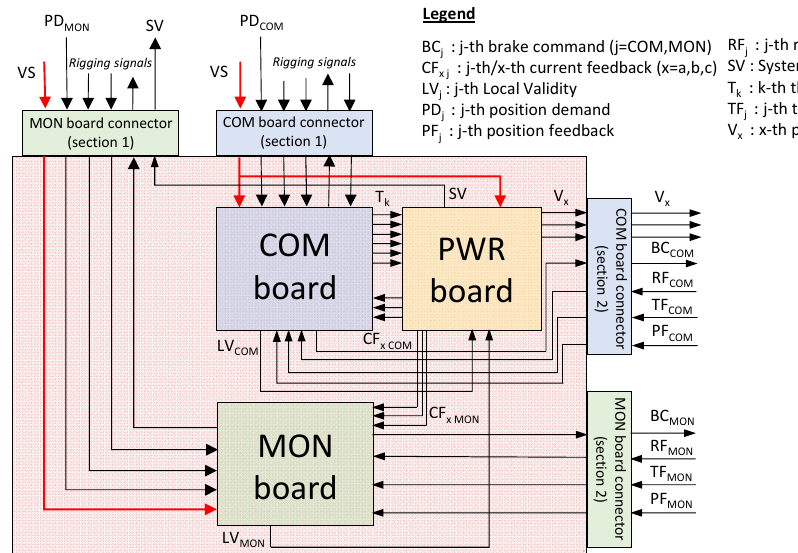
Figure 4. ACE: schematics of boards interfaces.